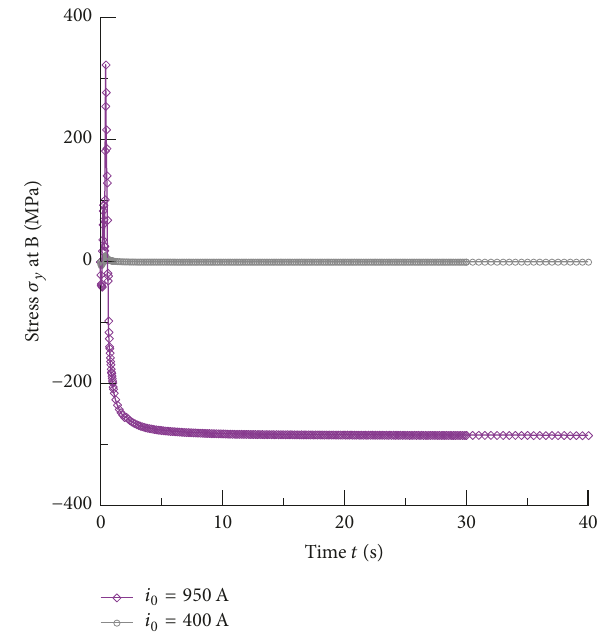
Figure 13: Time-history of stress near crack tip under different electric loads.